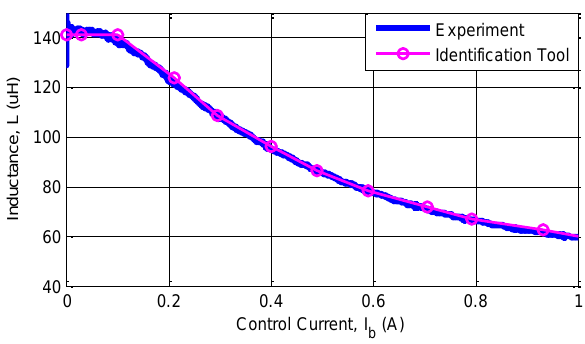
Figure 16. Inductance calculation from experimental